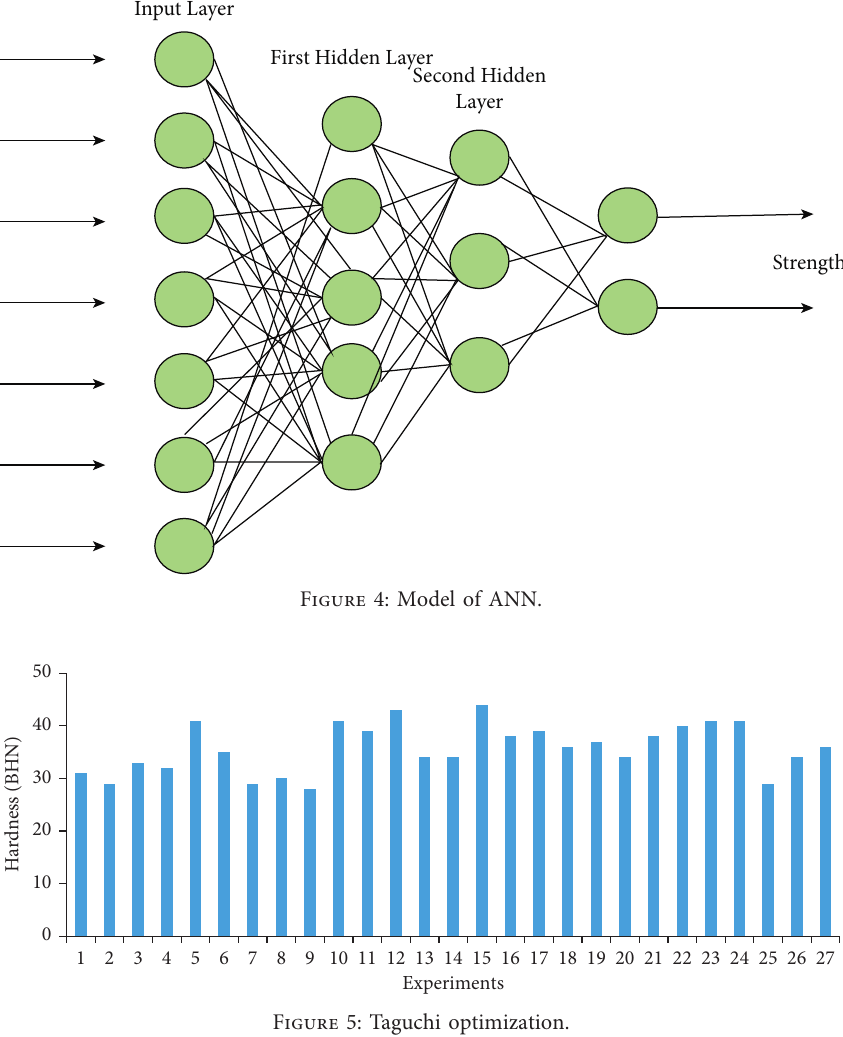
Figure 4: Model of ANN.